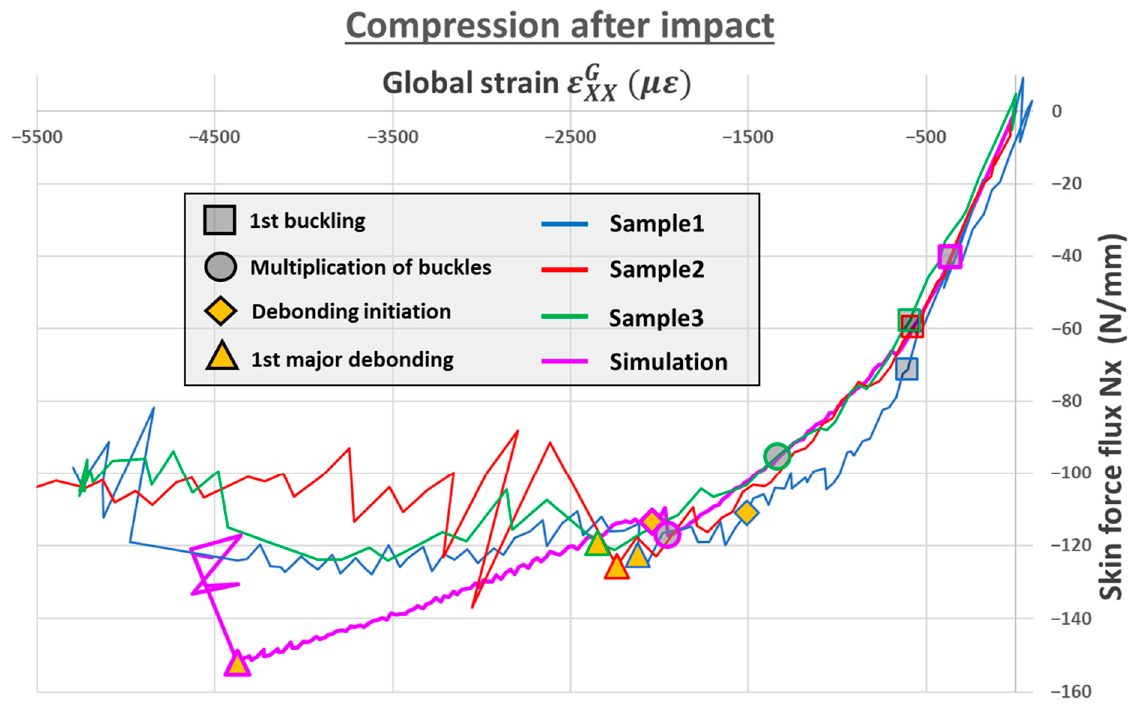
Figure 28. Longitudinal force flux against global strain for the three tests considered and the simu- lation from Section 3.